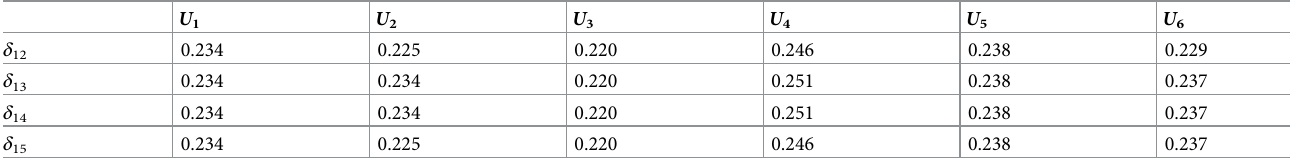
Table 9. The transformed probability of alternative O 1 to others.